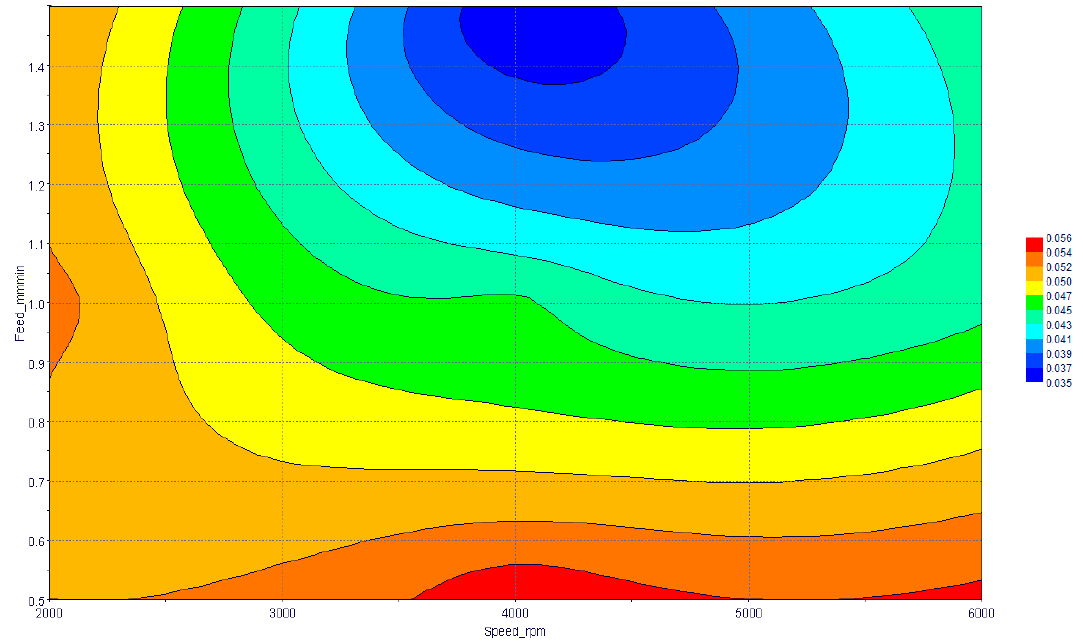
Figure 11. Combined effects of speed and feed rate on cylindricity.